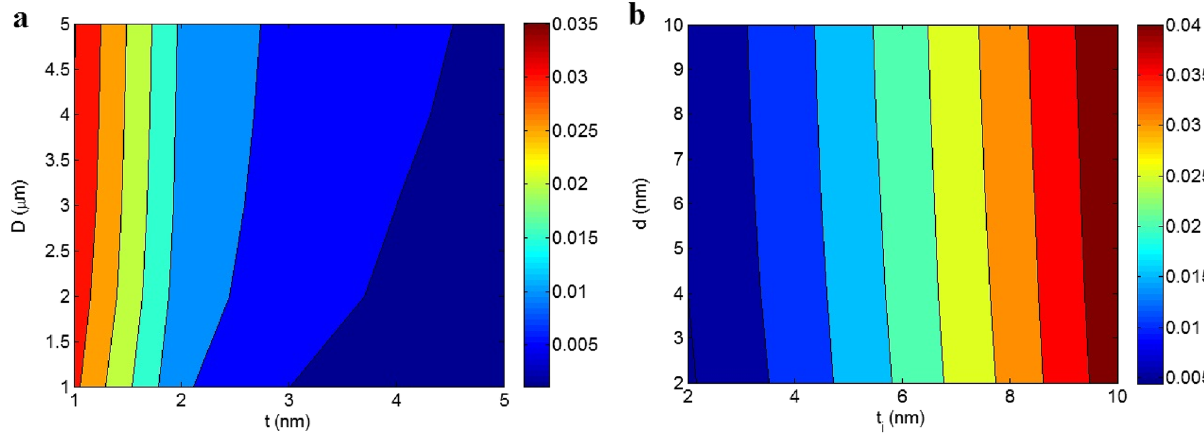
Figure 1. Contour plots for the dependencies of “ φ N ” on ( a ) “t” and “D” and ( b ) “t i ” and